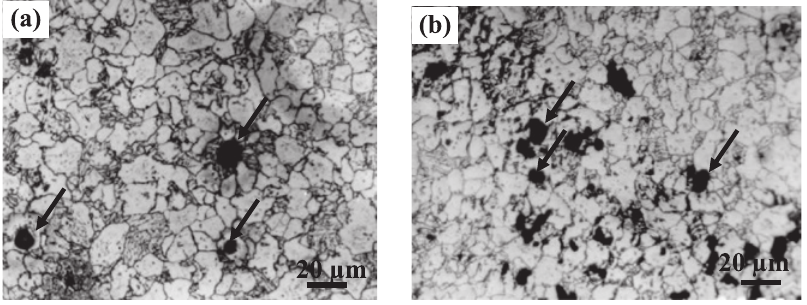
Fig. 8: Microstructures (a) in the vicinity of rupture and (b) opposite to rupture zone showing micro-voids.